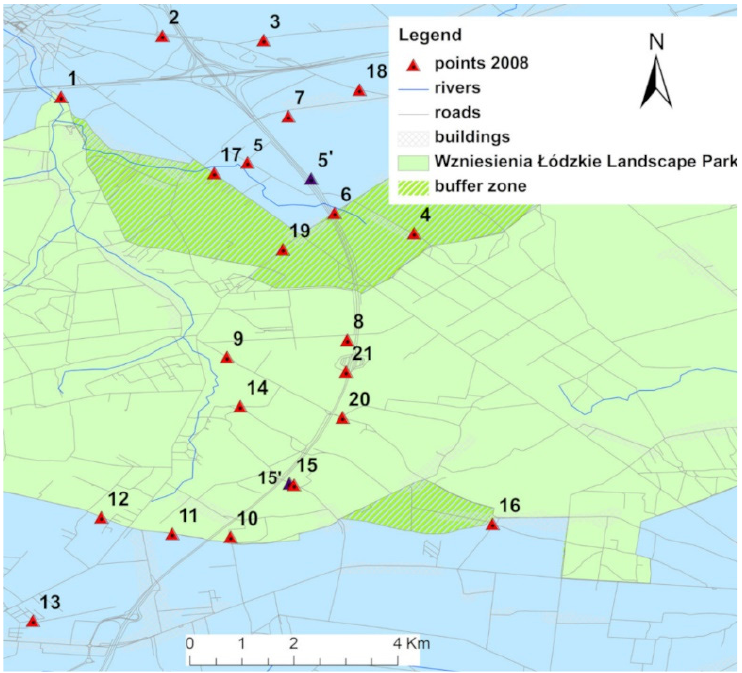
Figure 2. Location of sampling sites (5’ and 15’—points 2016).